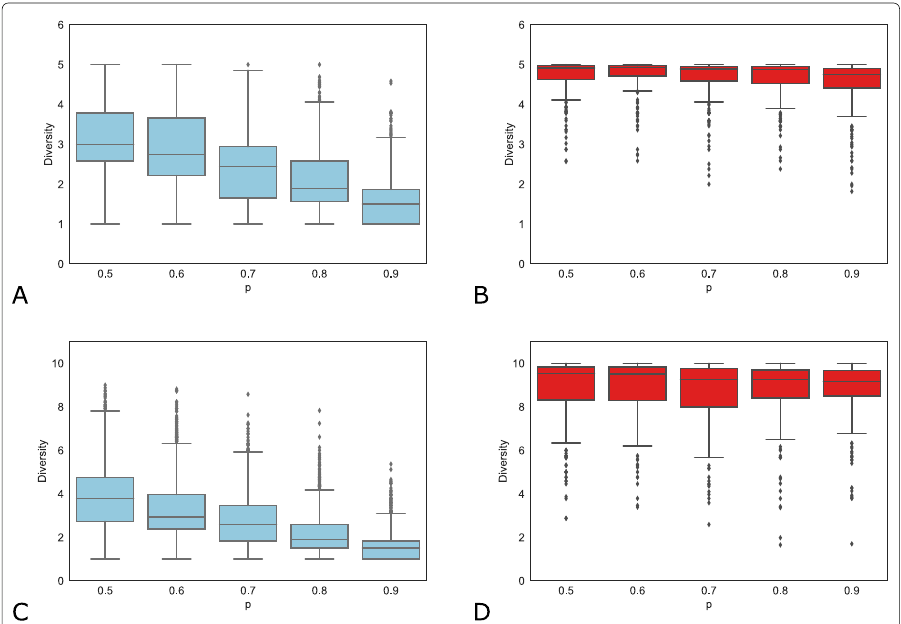
Fig. 4 Comparison of diversity in height-based antichain partitions (red boxes on right) versus siblinarity communities, based on common successors (blue boxes on left) in the Price model with five fields (top row, a and b ) and ten fields (bottom row, c and d ) and different intraconnectivity probability p . We studied ten networks of 5,000 nodes for each set of parameters. Figures show that the diversity of siblinarity antichains is clearly significantly smaller than that of heights. The box extends from the lower to upper quartile values of the data, with a line at the median. The whiskers extend from the box to show the range of the data. Flier points are those past the end of the